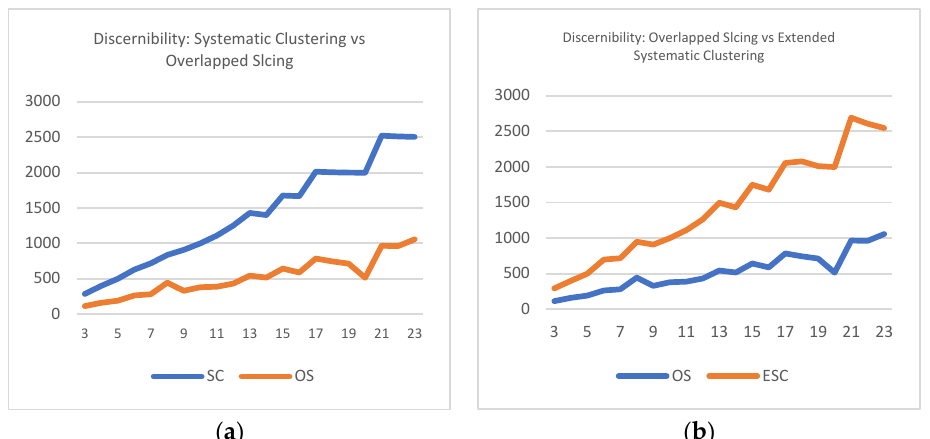
Figure 2. Discernibility value ( a ) overlapped slicing vs systematic clustering, ( b ) overlapped slicing vs extended systematic clustering.